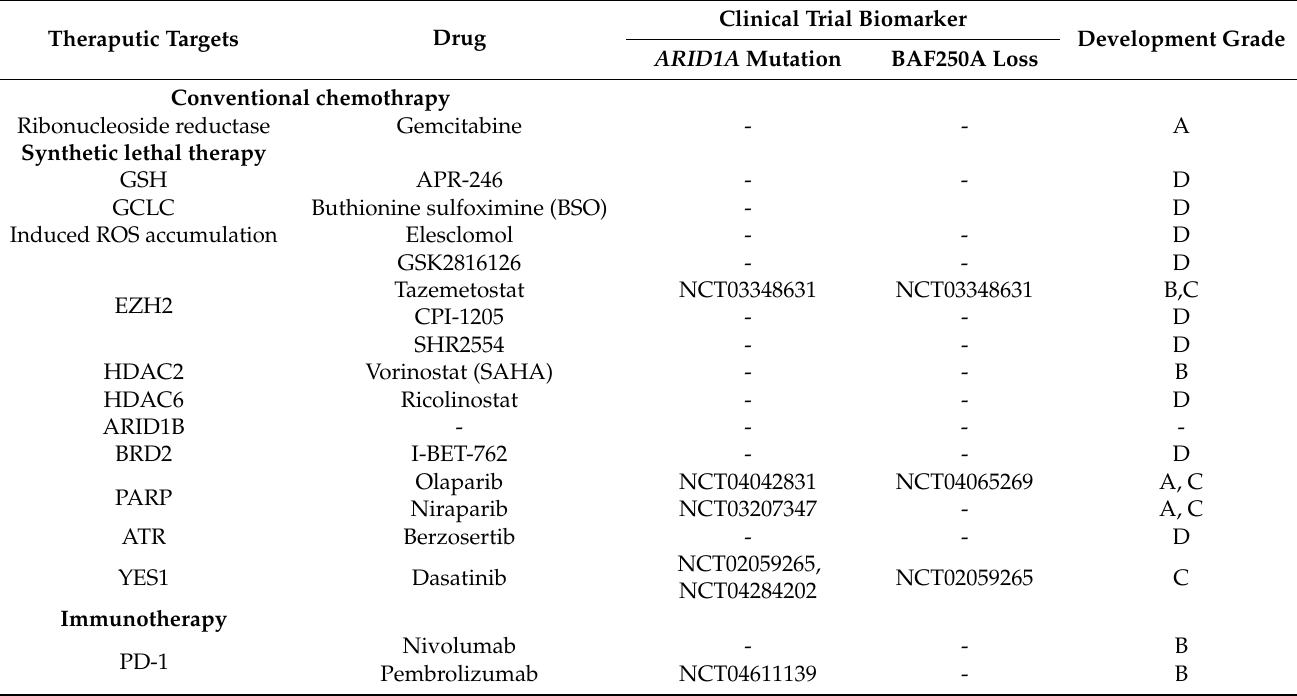
Table 1. ARID1A-target therapy.